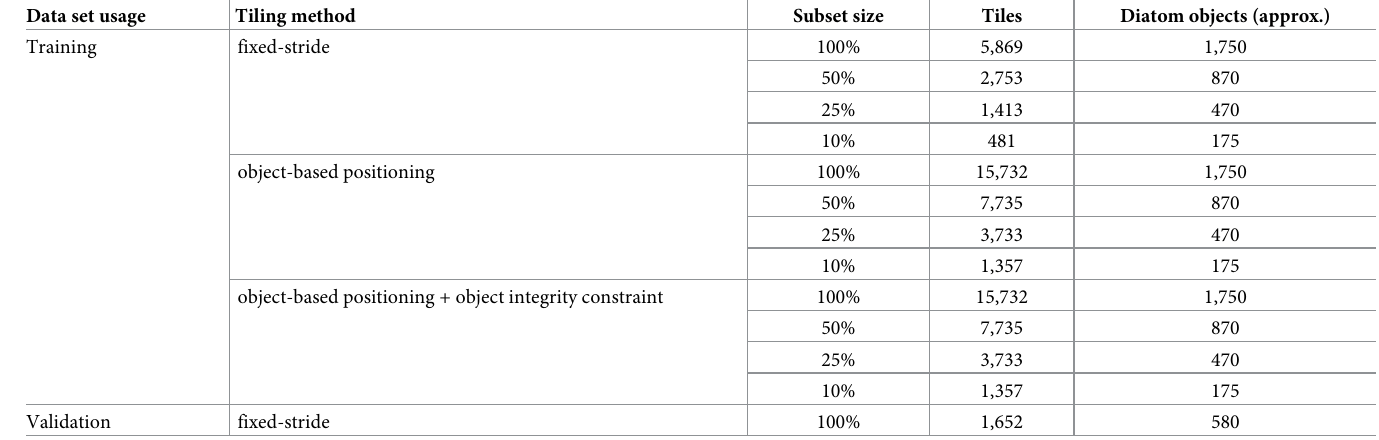
Table 1. Description of data